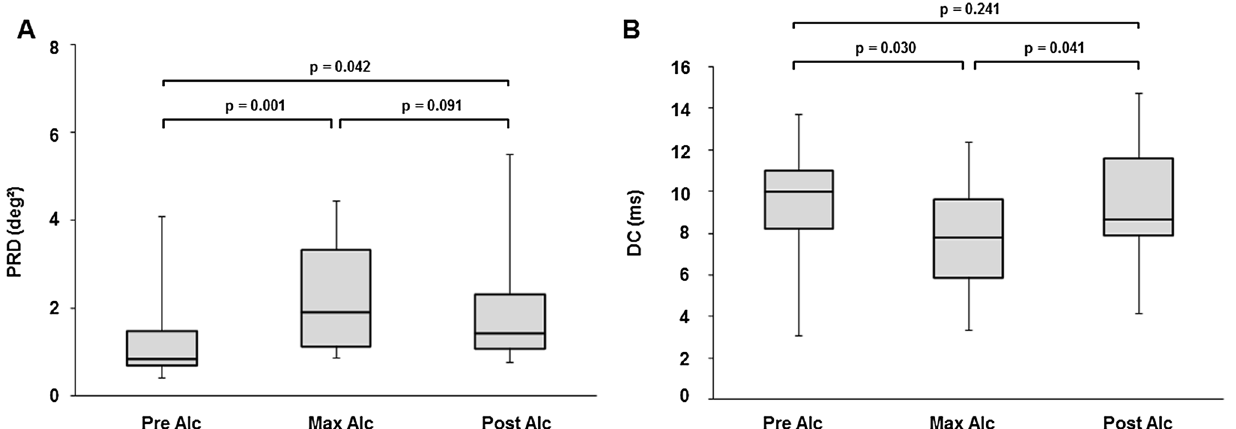
Figure 2. Median levels of ( A ) periodic repolarization dynamics (PRD) and ( B) deceleration capacity (DC) before starting the alcohol infusion (Pre Alc), at the time of maximum breath alcohol concentration (Max Alc), and after alcohol concentration dropped to approximately 0.05 mg/l (Post Alc). Error bars indicate the interquartile range. One outlier at Max Alc (PRD = 10.19 deg 2 ) not depicted. N = 15 for all experiments and analyses. Differences were tested by the Wilcoxon signed-rank